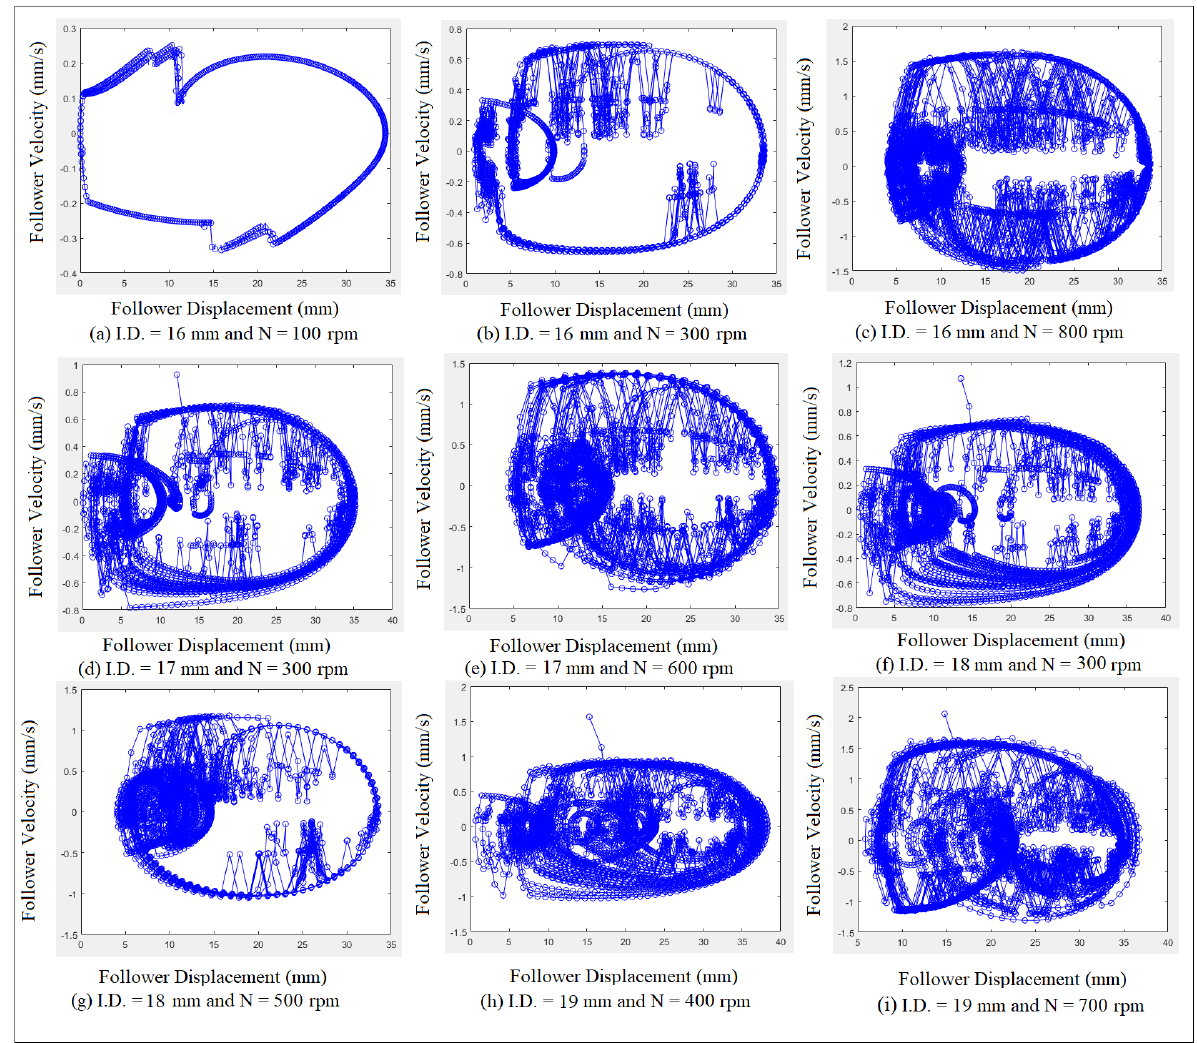
Figure 30. Phase-plane mapping for cam profile no.(2) at different (I.D.) and different (N).